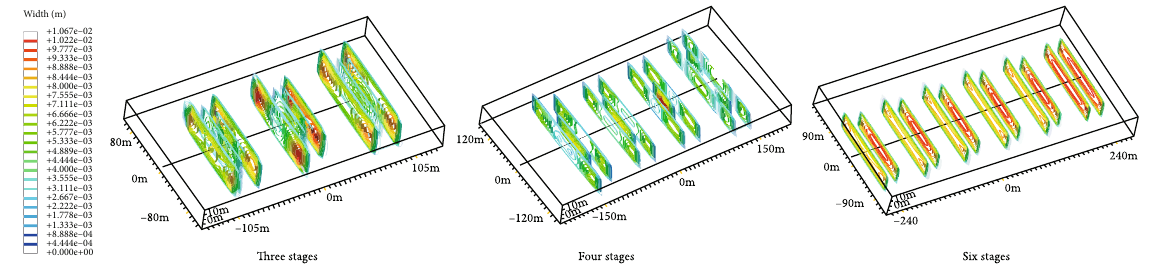
Figure 1: Fracture geometries of di ff erent stage and cluster numbers.